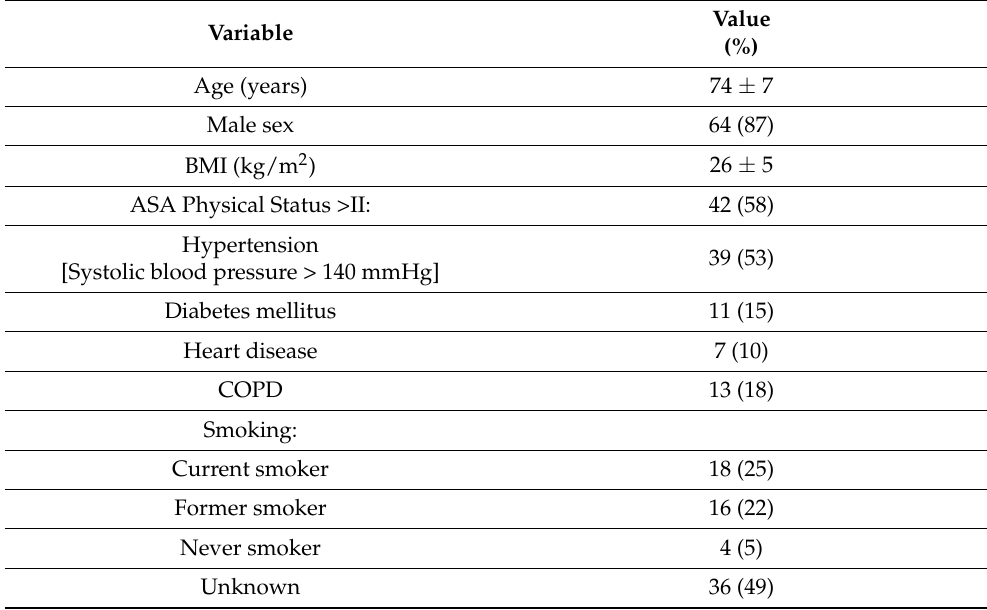
Table 1. Baseline total patient characteristics 1 .